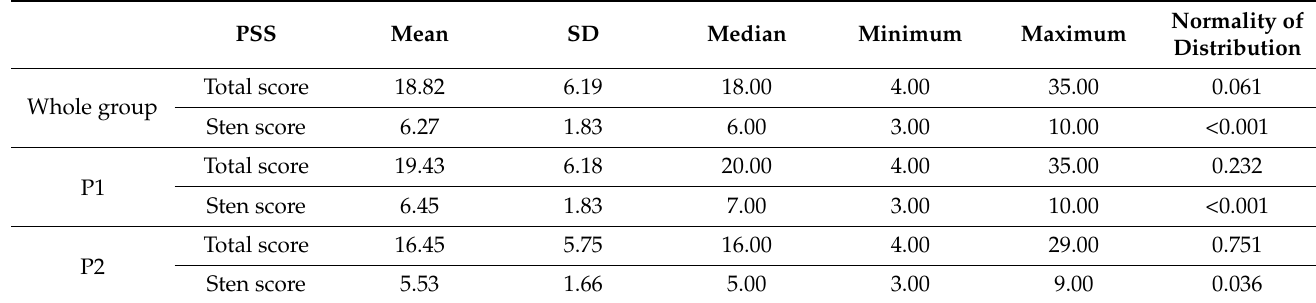
Normality of Distribution